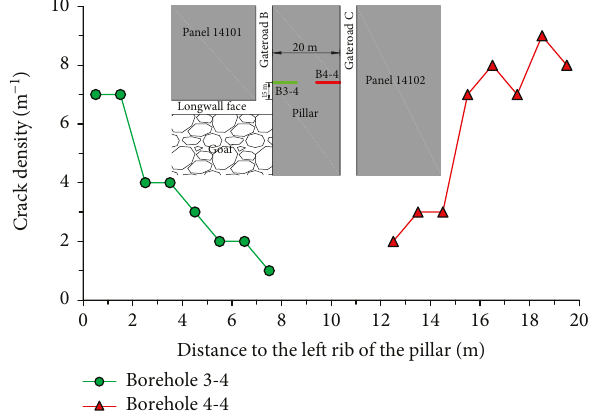
Figure 5: Fracture density observed by endoscope in a chain pillar (data from